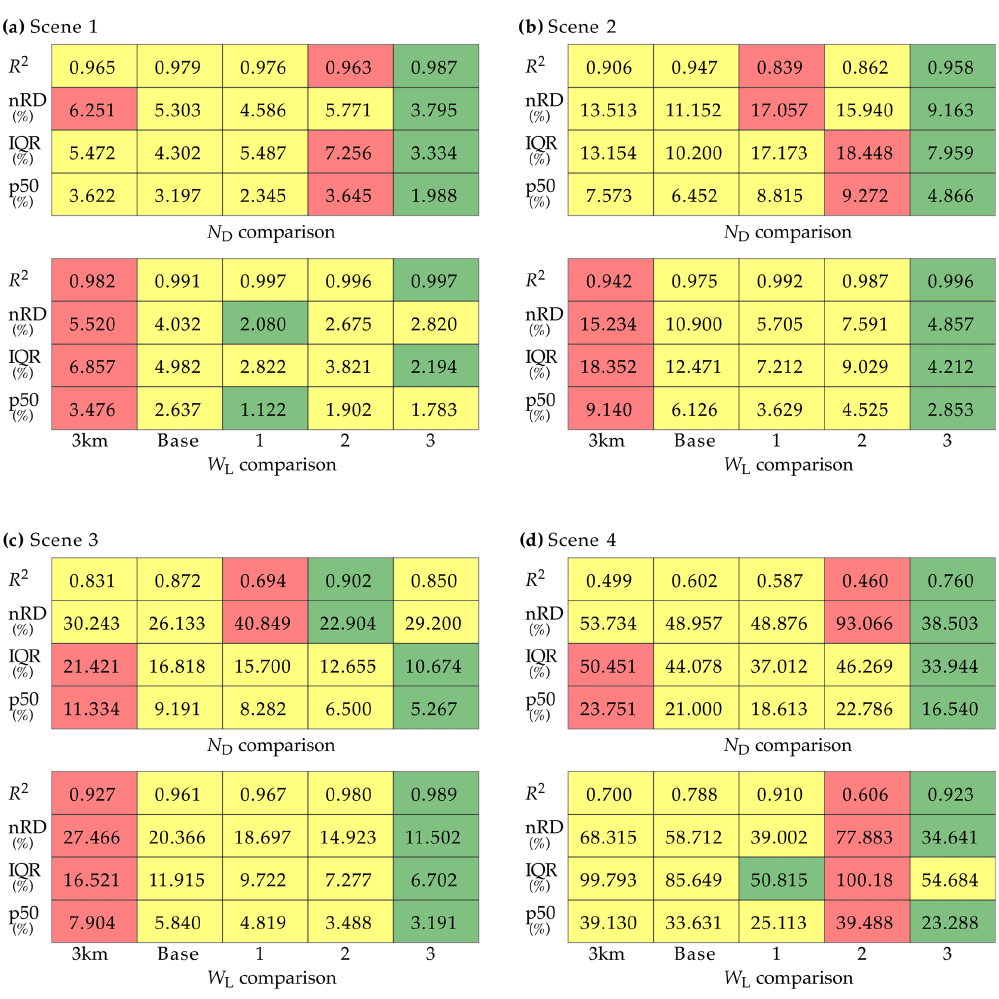
Figure 10. (a) Comparison of derived liquid water path ( W L , c , d ) and droplet number concentration ( N D , a , b ) from the native LRES (at a scale of ≈ 3km) and baseline retrievals, as well as the downscaling experiments 1 (statistical downscaling approach), 2 (constant reflectance ratio approach), and 3 (adjusted lookup table approach with LUT slope adjustment), and the respective reference results. Parameters to quan- tify the comparisons are the median of the relative difference to the reference (p50), relative interquartile range (IQR; 75th–25th percentile of the relative difference to the reference), normalized root-mean-square deviation (nRD; defined as the RD between the two data sets, nor- malized by the average reference retrieval), and the explained variance ( R 2 ). Green colors indicate the experiment that compares best to the reference results, i.e., highest R 2 and lowest p50, IQR, and nRD. Red colors indicate the experiment with the worst agreement with the reference retrievals, while yellow colors indicate all experiments in between. Data are from example scene 1 sampled on 1 June 2013 at 10:05UTC. (b) – (d) Same as (a) but for example scenes 2 to 4,